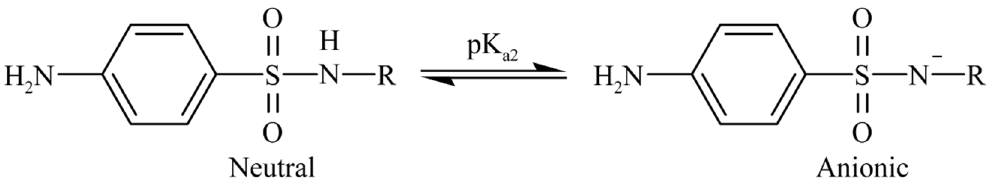
Scheme 1. Schematic diagram of a transition from a neutral to anionic sulfonamide species.